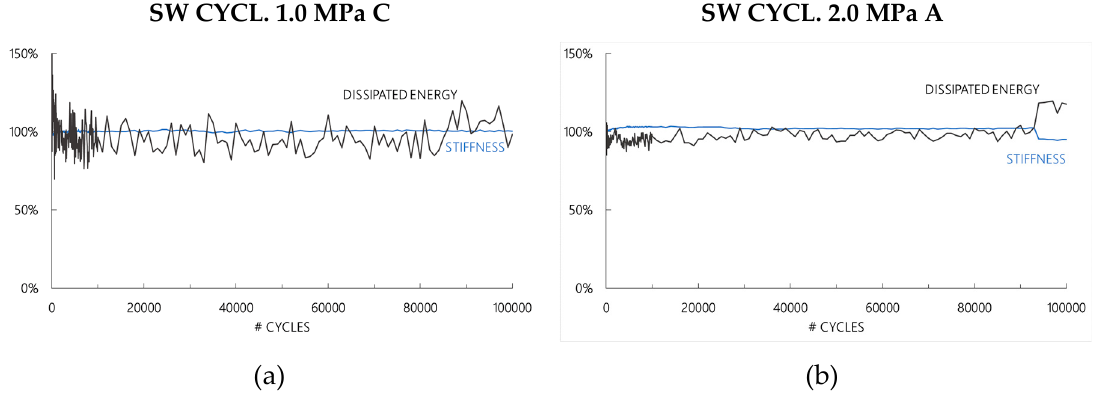
Figure 15. The evolution of the stiffness and the dissipated energy of sandwich beams during the loading–unloading cycles: ( a ) an uncracked sample and ( b ) a cracked sample. Table 9. Number of cracks formed during cyclic preloading of the sandwich beams.